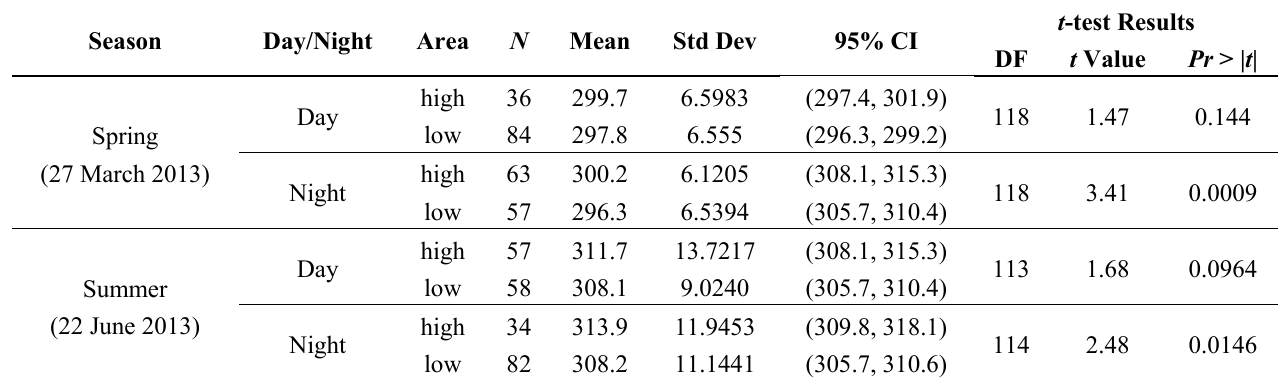
Table 4. Hypothesis test output.